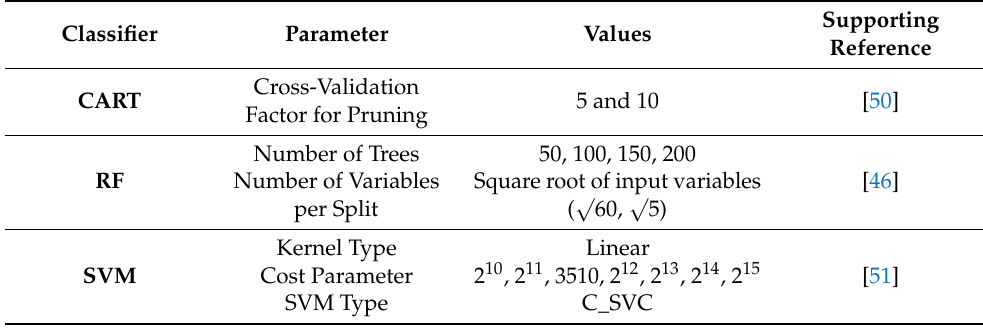
Table 2. Input parameter values used for different classifiers available in the